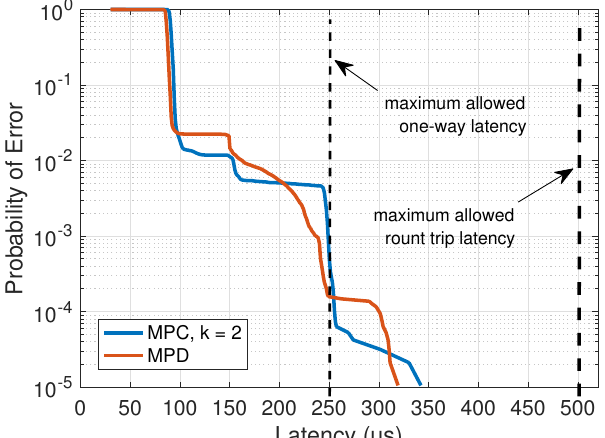
Figure 9. UDP latency functions for MPC with k = 2 and MPD when adding a delay to fronthaul path 2. The dashed line represents the maximum latency to be supported by the MAC–PHY split